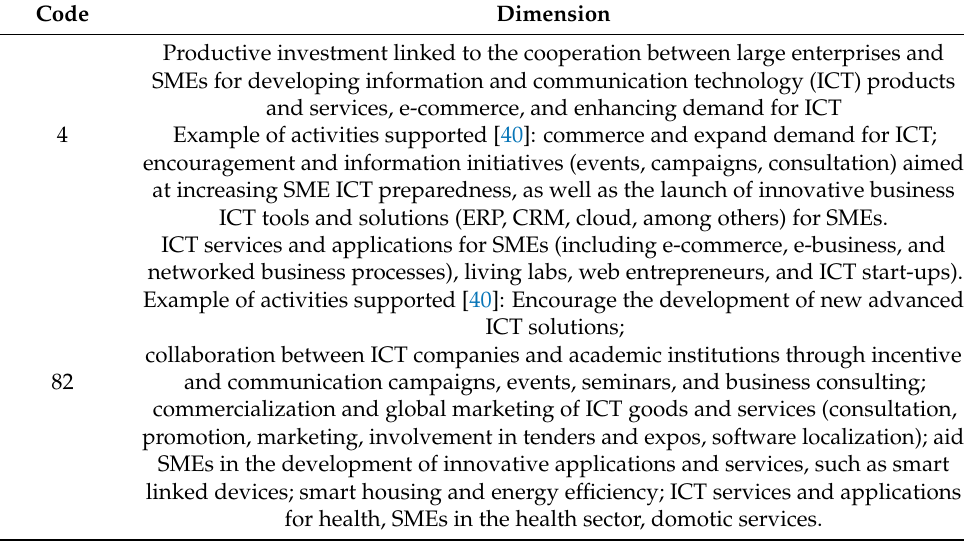
Table 2. Dimensions of intervention